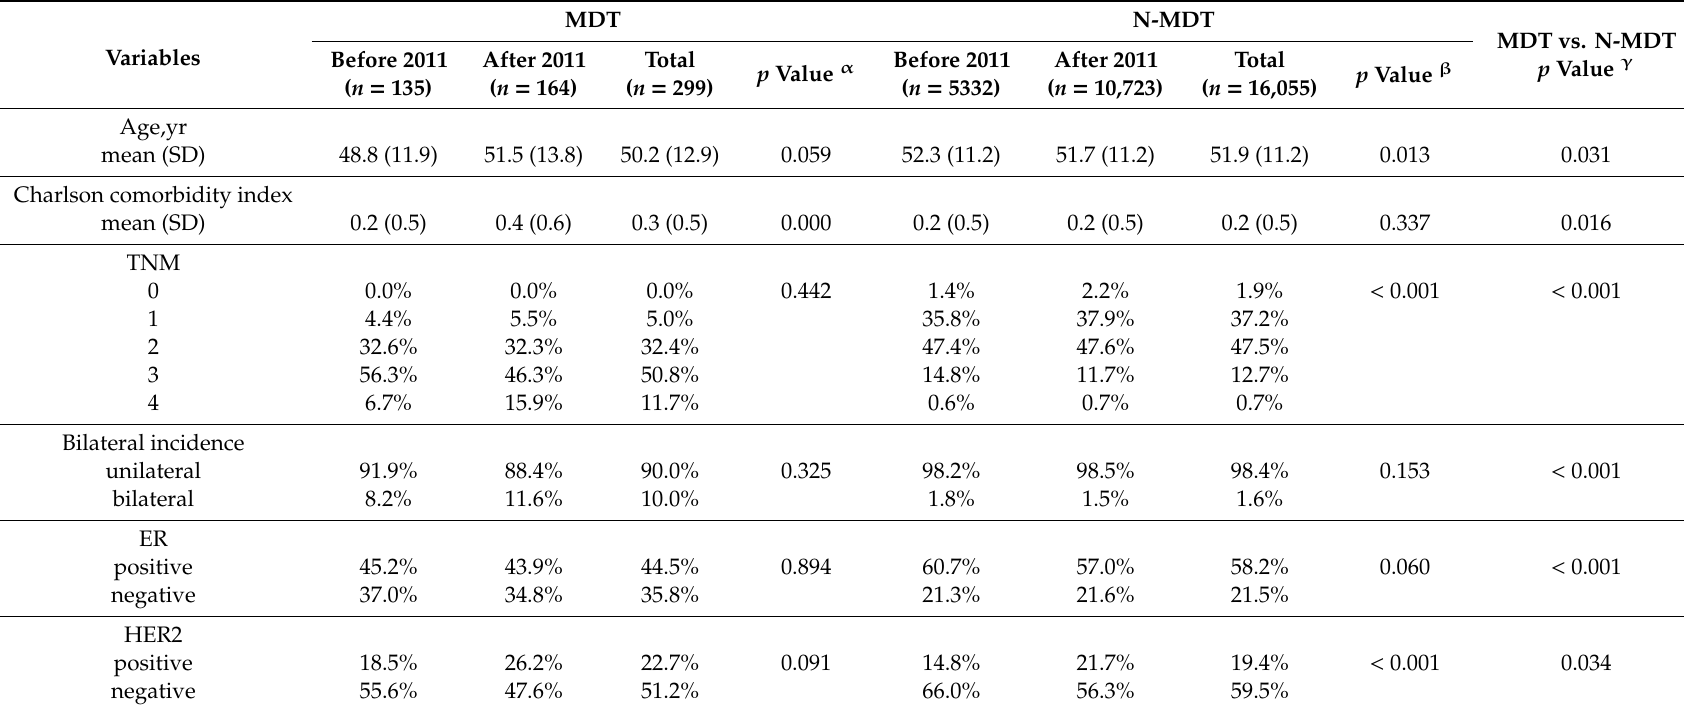
Table 2. Basic characteristics of pre-PSM of the sample